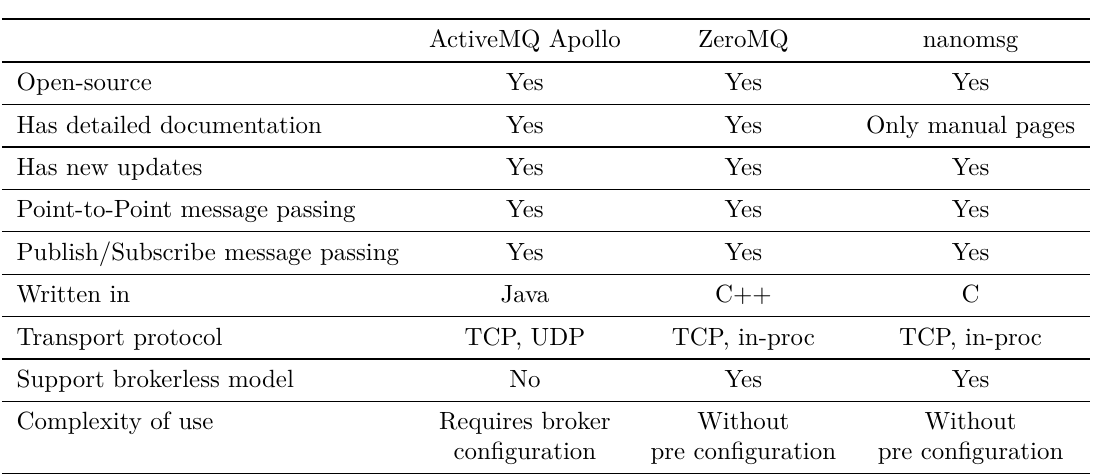
Table 1. A brief comparison of message oriented